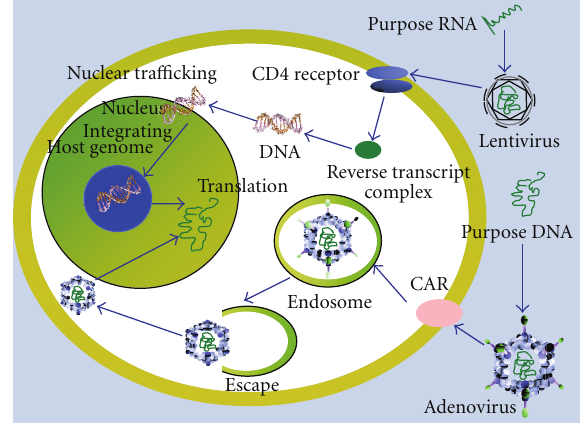
Figure 1: The mechanism of transfection using nonviral carriers.